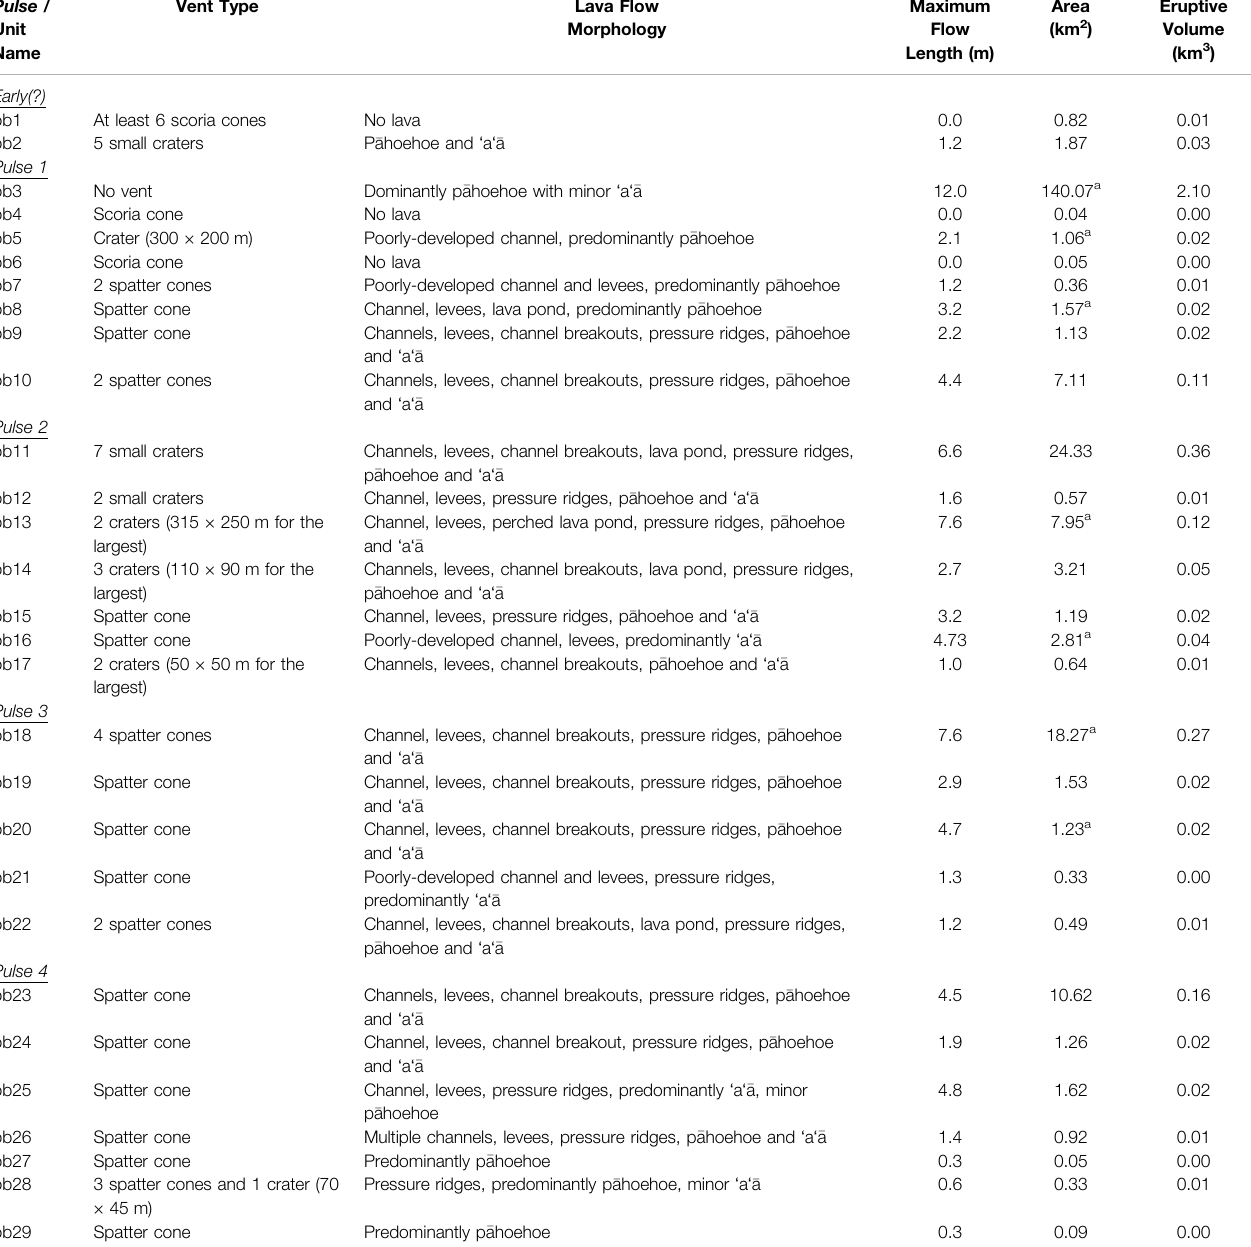
TABLE 5 | Characteristics of the different vents and lava fl ows associated with eruption of the Brushy Butte fl ow fi